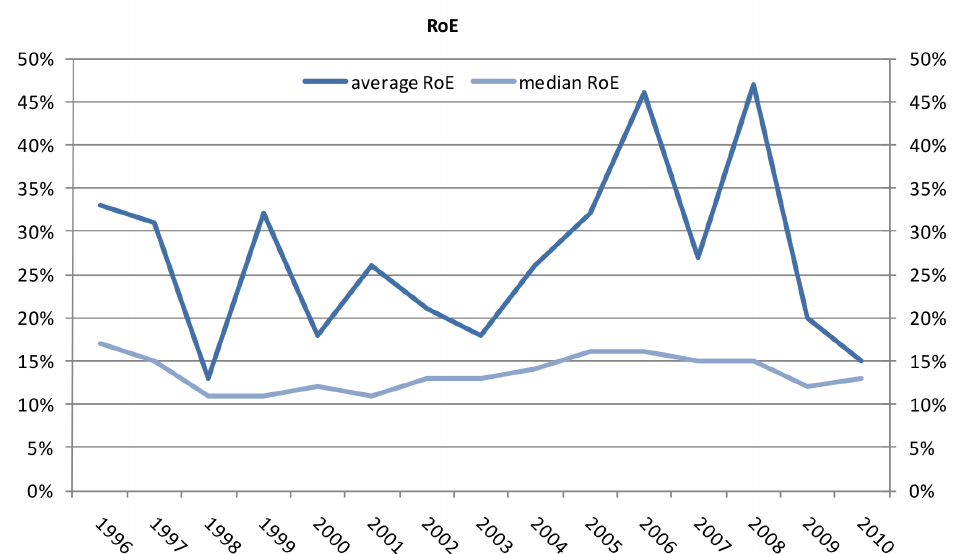
Figure 5. MFI RoE. Data from 1897 Microfinance Institutions extracted only from MFIs with positive RoE and positive Net Income after tax (Mix,